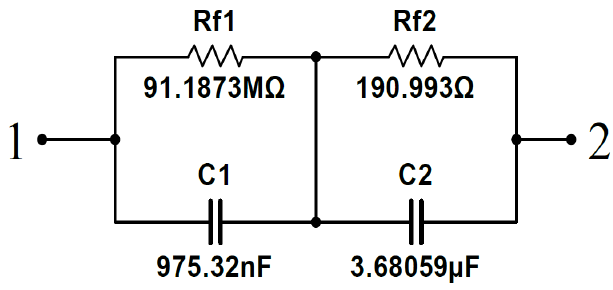
Figure 3. Chain fractance (CF) approximation of Equation (9).